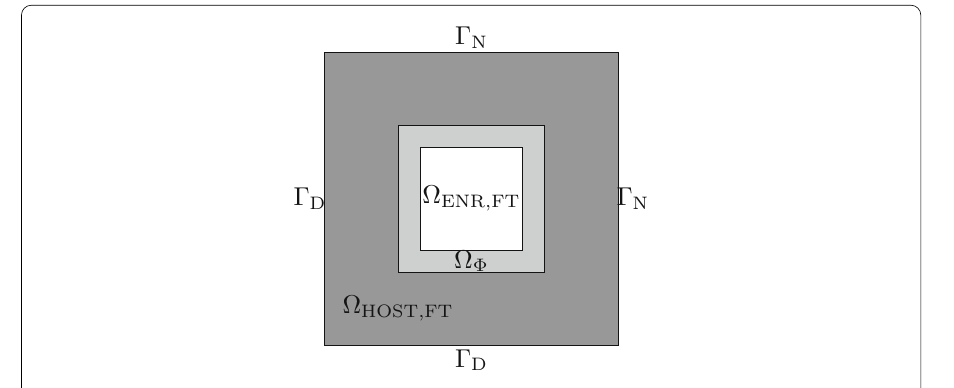
Fig. 1 Sketch of smooth model problem in two dimensions depicting the employed partitioning of the domain (cid:5) into (cid:5) HOST , FT (drak gray), (cid:5) (cid:6) = (cid:5) HOST ∩ (cid:5) ENR (light gray), and (cid:5) ENR , FT (white). The boundary data for this model problem is given by g = 0 on (cid:7) D and h = (1 , 1) T · n on (cid:7) N where n denotes the outer